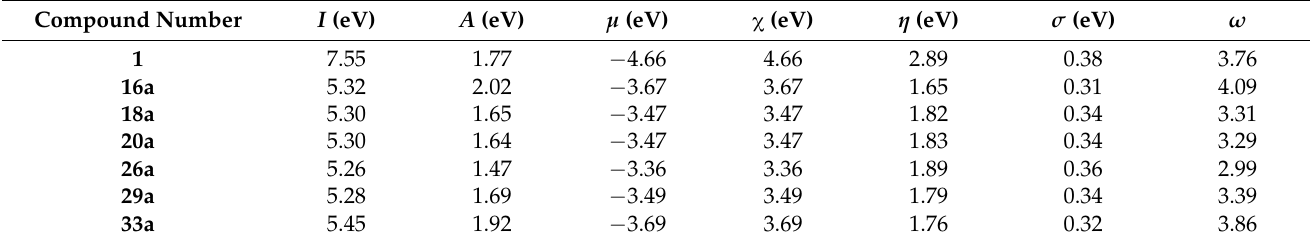
Table 5. Global descriptors of chemical reactivity of structures 1 , 16a , 18a , 20a , 26a , 29a and 33a . Compound